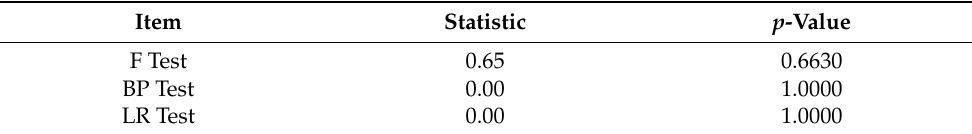
Table A2. Test of the month individual